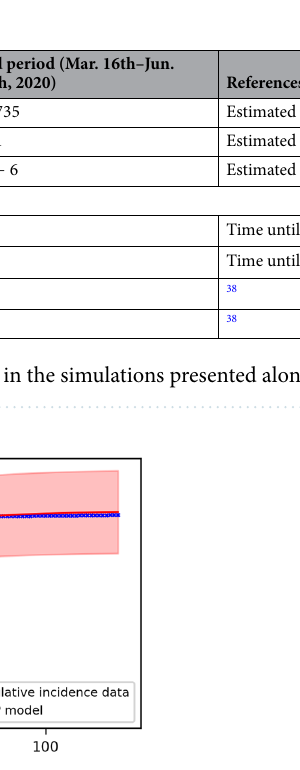
Figure 3. Estimated cumulative incidence compared to the real data. The fitting process of the model was separated on the two shown time-regions, one before the start of the lockdown and one after. The initial condition for the simulation was extracted from the first measured value of the dataset, and the number of cumulative cases distributed proportionally among the four capital cities of the provinces and the capital of the region (Santiago de Compostela).